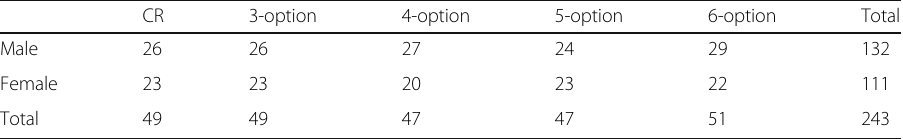
Table 2 Descriptive statistics: participants ’